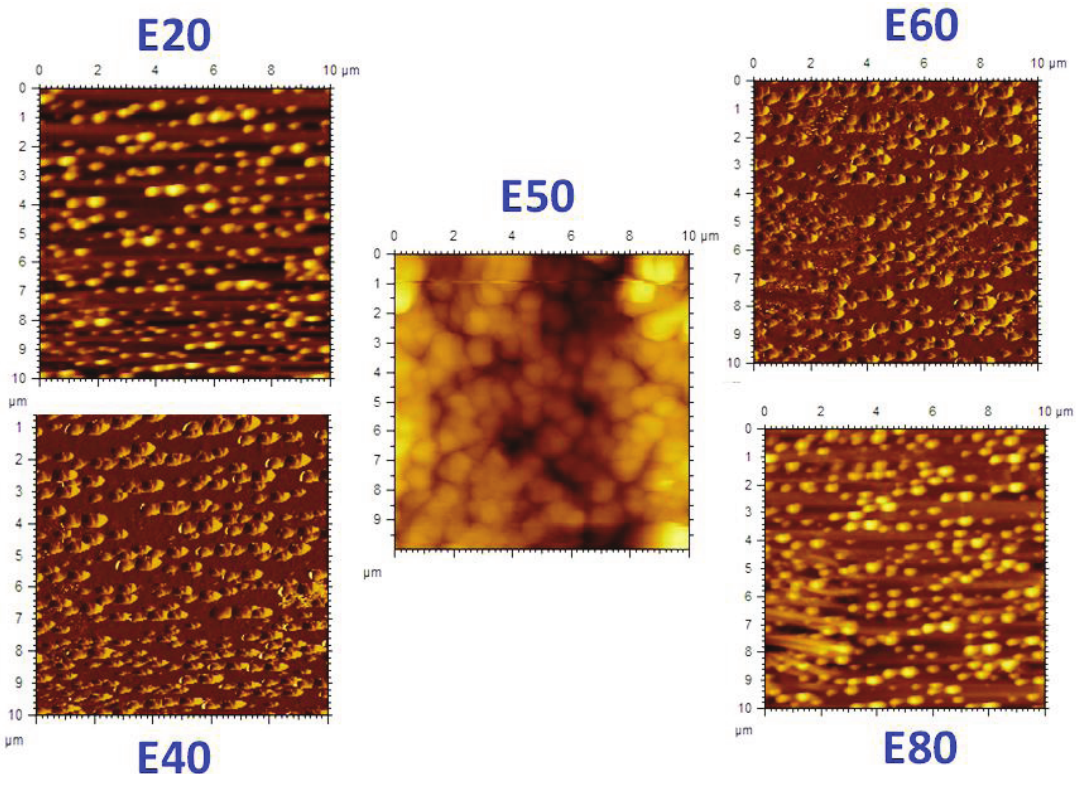
Figure 9: AFM Phase analysis of the various blends